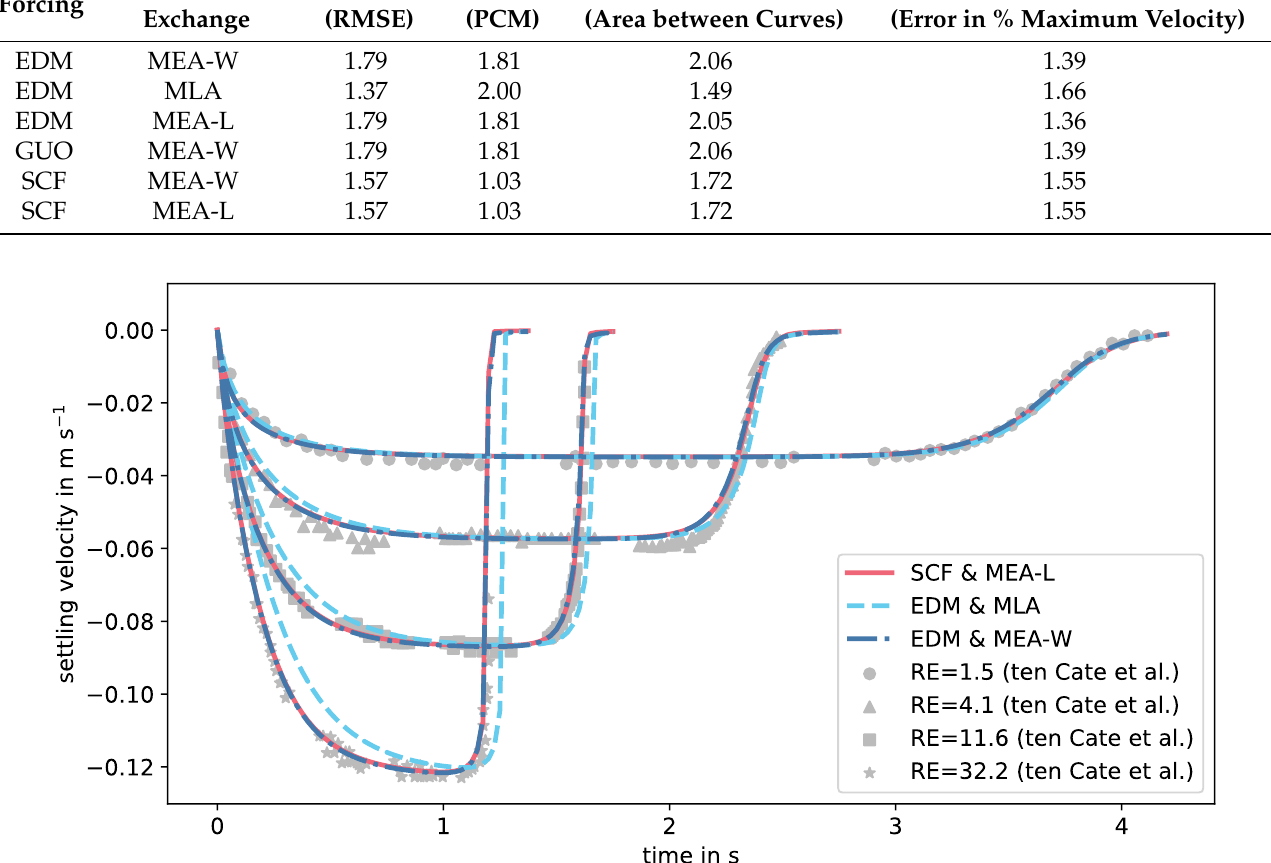
Figure 2. Settling velocity in the four defined cases for different combinations of forcing and momentum exchange schemes along with the experimental results by ten Cate et al. [49].